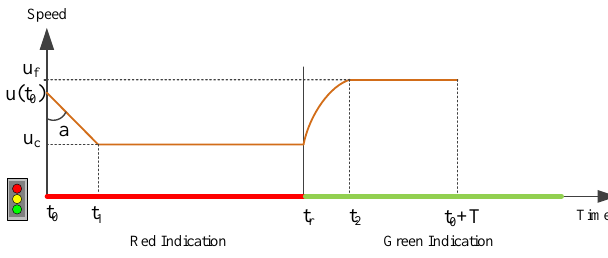
Figure 1. The fuel-optimized vehicle trajectory.